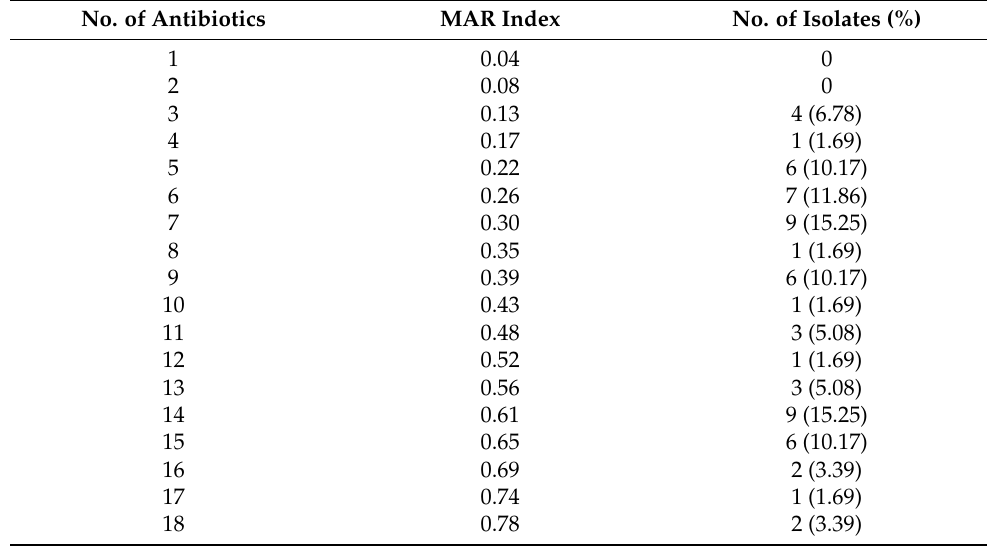
Table 4. Multiple antibiotic resistance (MAR) indices of Escherichia coli and Klebsiella pneumoniae